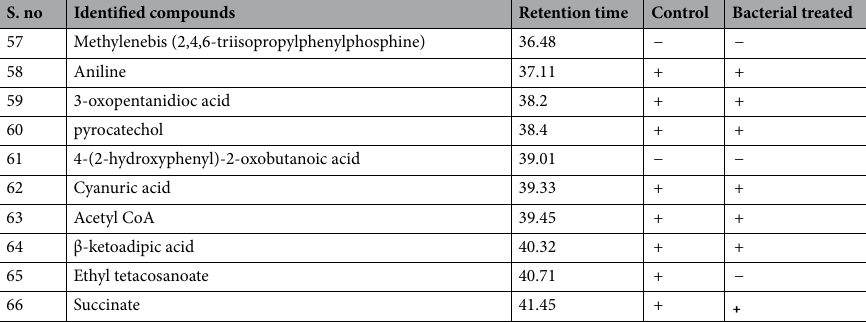
Table 4. Identified organic compounds from untreated effluent (control) and bacterial treated effluent by GC– MS